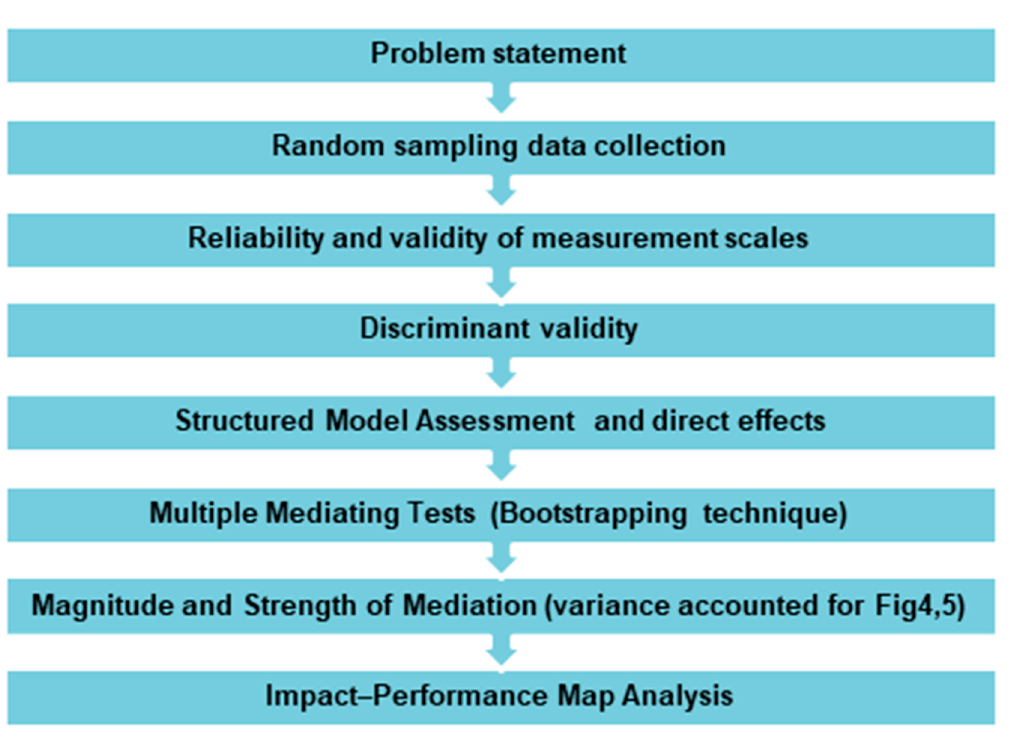
Figure 3. Steps in Figure 3. Steps in methodology.